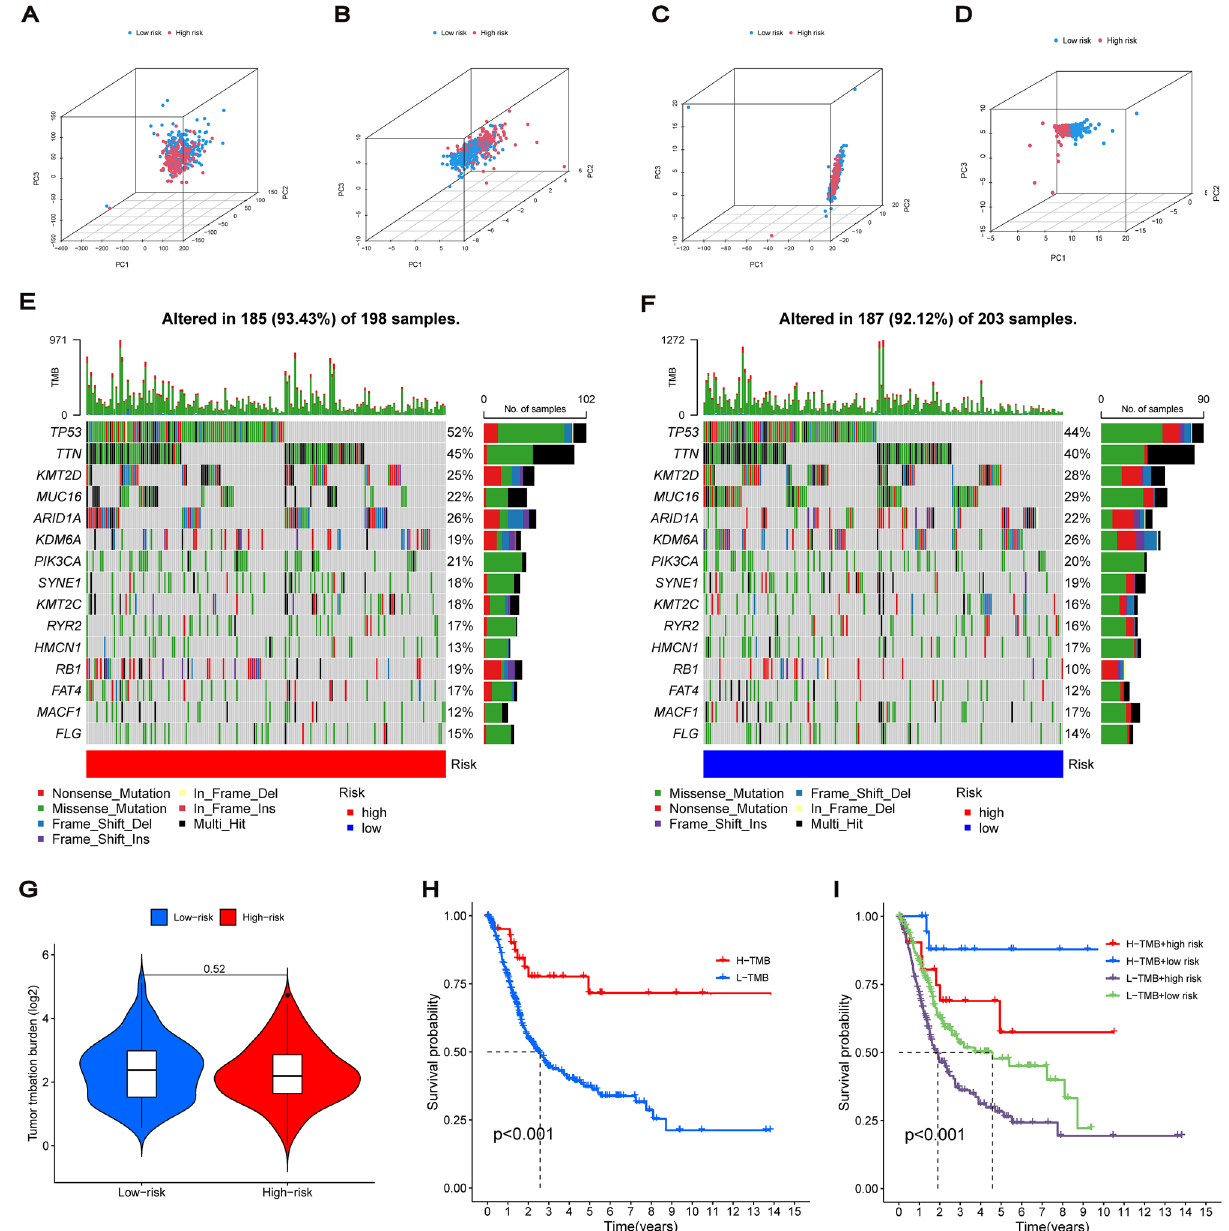
Figure 7. Principal Component Analysis and Tumor Mutation Burden. ( A – D ) 3D scatterplot of sample distribution between the low-risk and high-risk BC patients based on the entire gene expression profile, cuproptosis genes, cuproptosis-related lncRNAs, and the lncRNA profile of risk signature, respectively. ( E , F ) Waterfall diagram containing the top 15 genes with high mutation frequency in the low-risk and high-risk groups. ( G ) Tumor mutation burden for two groups. ( H ) Kaplan–Meier curves of OS for patients in high and low TMB subgroups. ( I ) Kaplan–Meier curve of OS for patients classified by TMB and risk